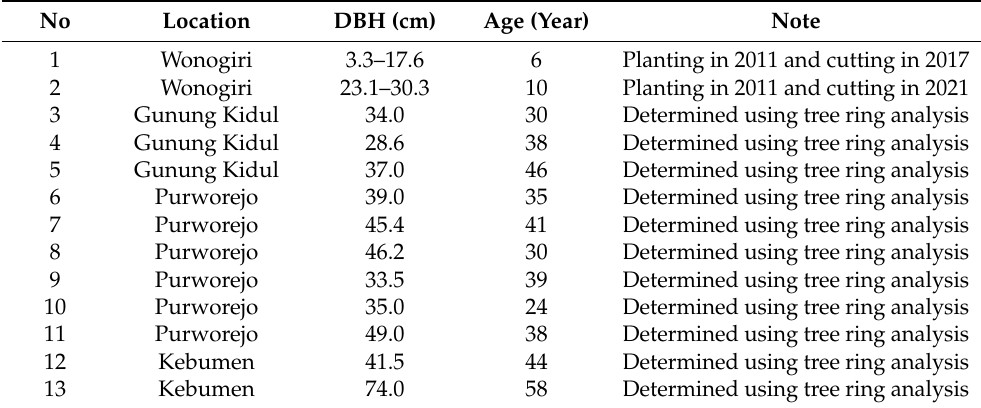
Table 2. The age of tree